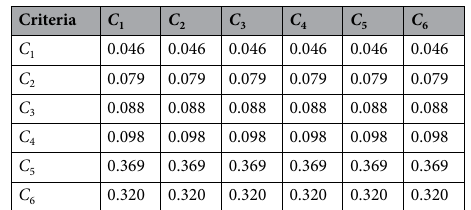
Table 7. The stable matrix of DANP when lim